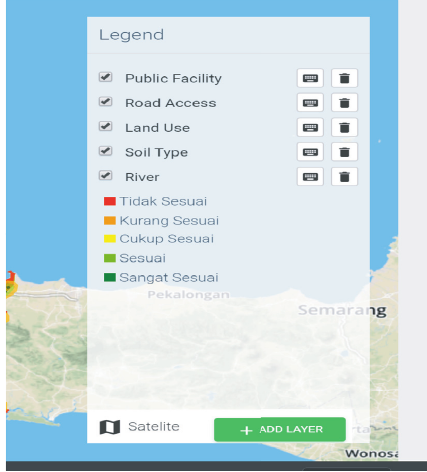
Figure 10: Data configuration.